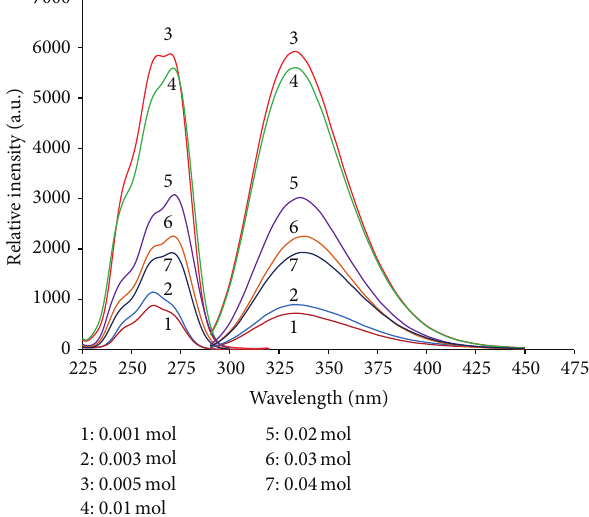
Figure 6: PL and PLE spectra of ( Ca (1−𝑥) Pb 𝑥 ) 0.003, 0.005, 0.01, 0.02, 0.03, 0.04), excitation spectra monitored at 335 nm emission, and emission spectra monitored at 270 nm excitation.